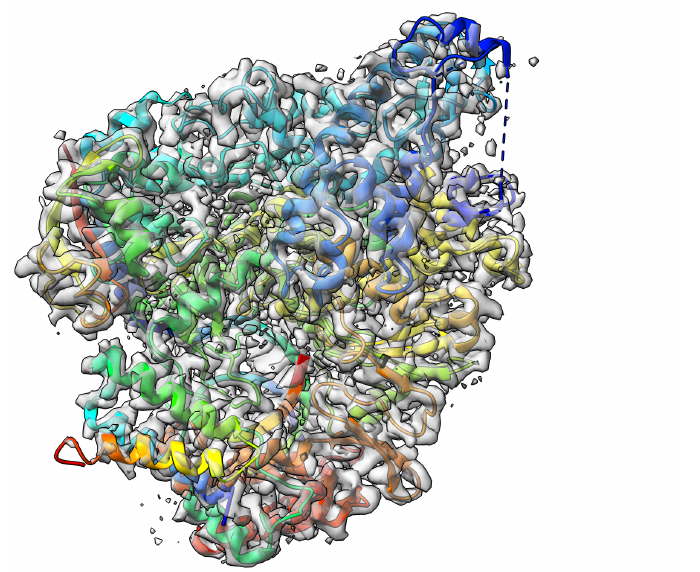
Figure 4. Target 202 (EMD-30210) map-model overlay at the recommended contour 0.058 (4.3 σ ) with T0202EM004_1